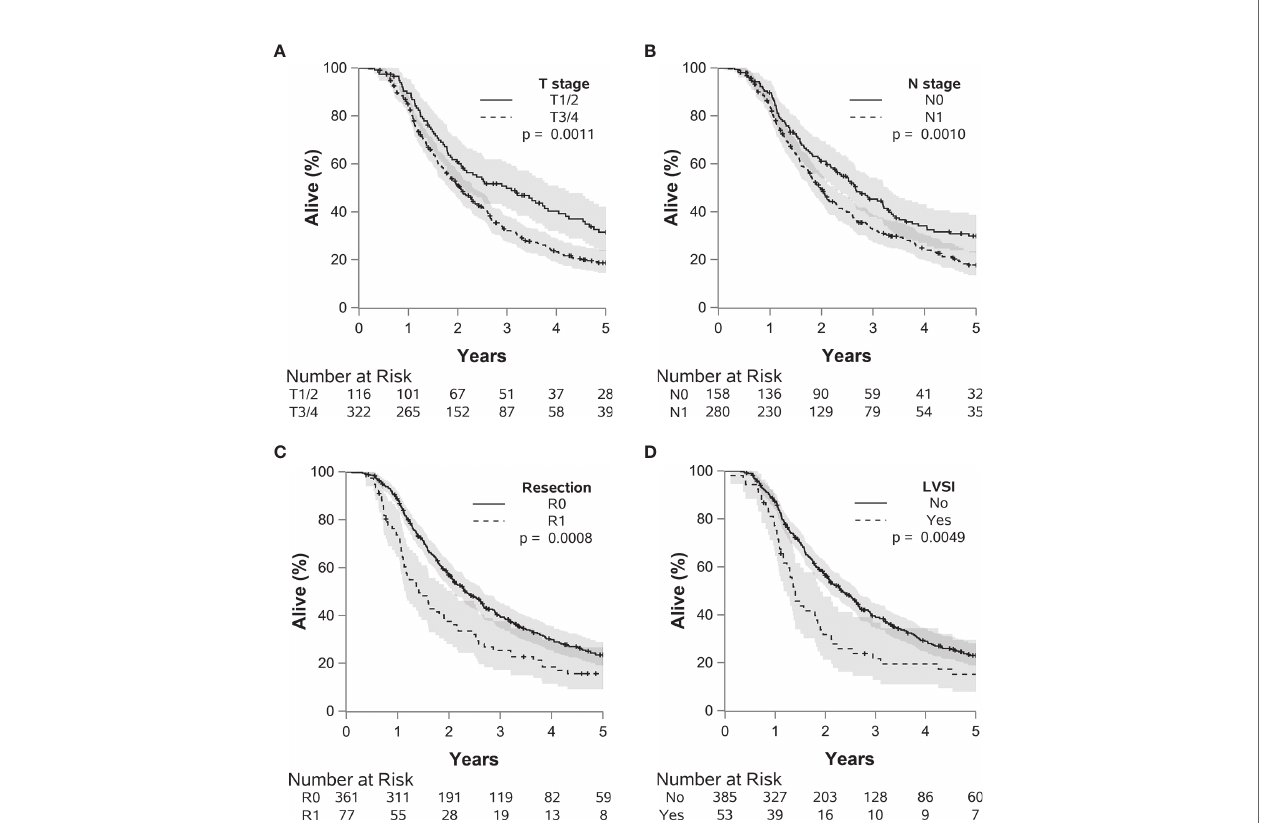
FIGURE 3 | The impact of many adverse pathologic factors on survival is portrayed, with (A) T 3 or 4 vs. 1 or 2 (p=0.0011), (B) N1 vs. N0 (p=0.0010), (C) R1 vs. R0 (p=0.0009), and (D) LVSI present vs. absent (p=0.0049) all reaching statistical signi fi cance. Grade 4 or 3 vs. 1 or 2 (p=0.061) demonstrated a potential statistical